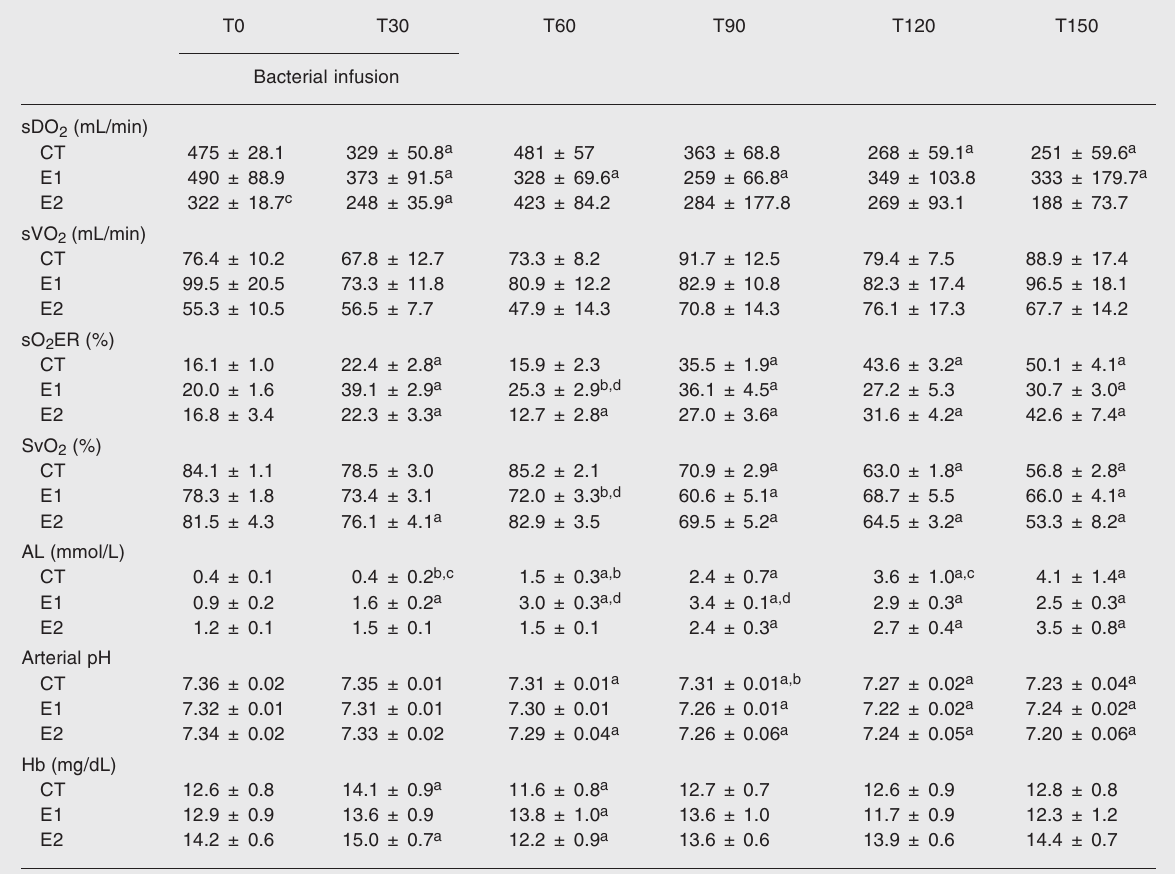
Table 1. Systemic oxygen-derived variables for all